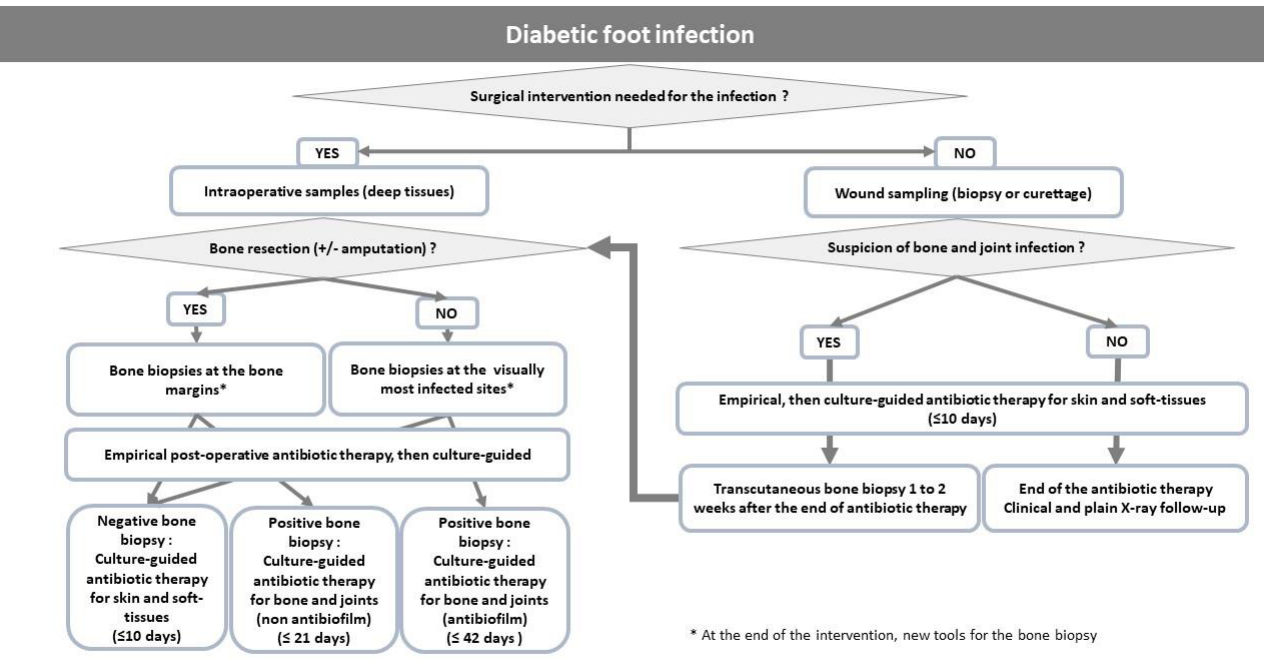
Figure 2. Propositions for the choice of anti-biofilm antibiotics and duration according to the type of diabetic foot infections. Table 2. Antibiotic regimens used in patients treated medically for diabetic foot osteomyelitis. Author (Ref)